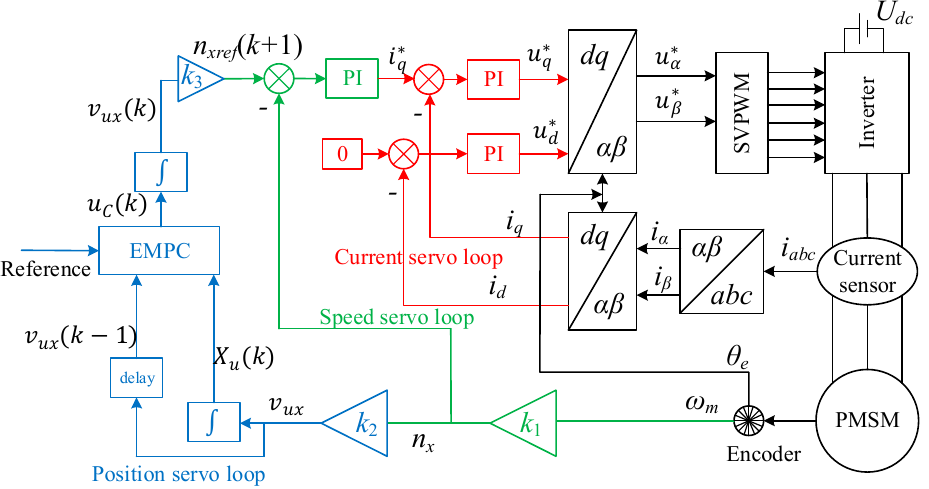
Figure 3. T hree-loop control of the crane in track-following servo subsystem. Figure 3. Three-loop control of the crane in track-following servo